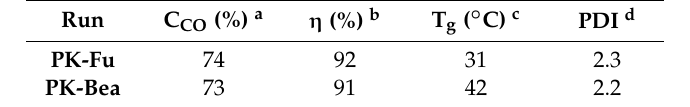
Table 1. Experimental results of PK modified with furfurylamine (PK-Fu) and benzylamine (PK-Bea). Run C CO (%) a η (%) b